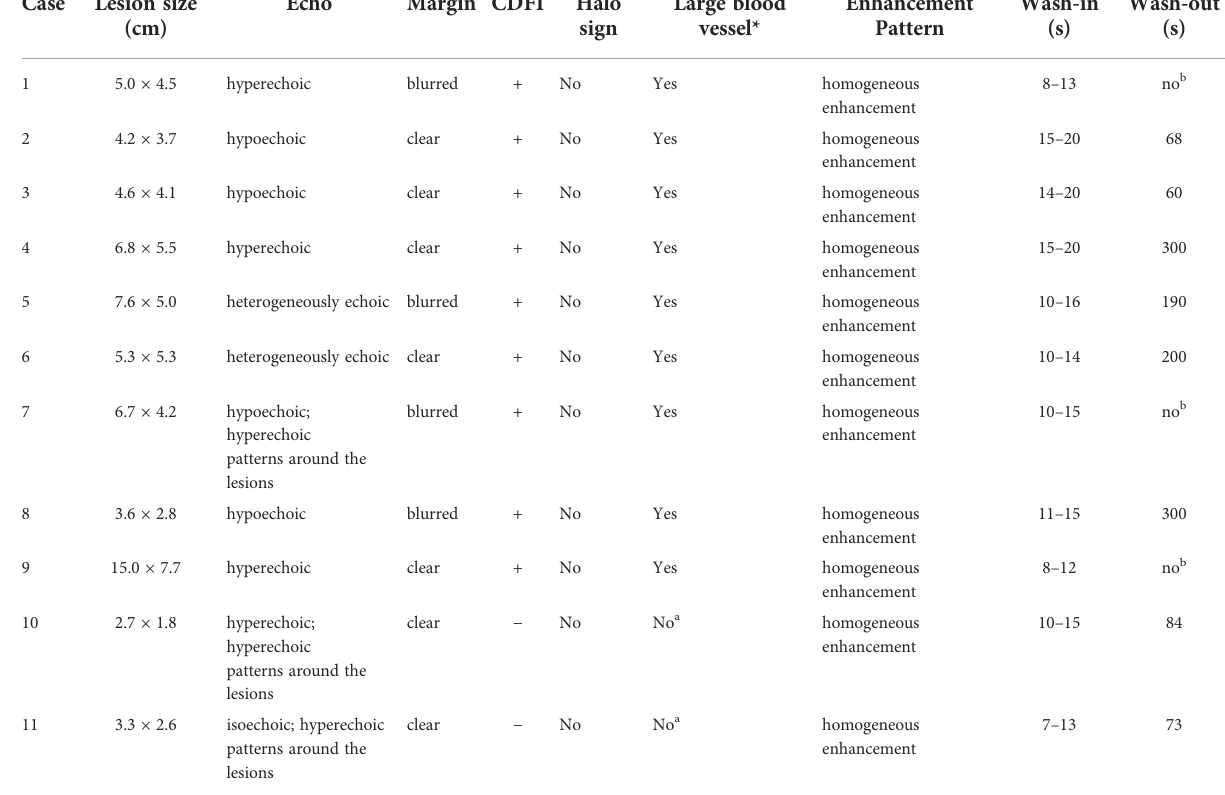
TABLE 3 Summary of Ultrasound/CDFI/CEUS fi ndings in patients.